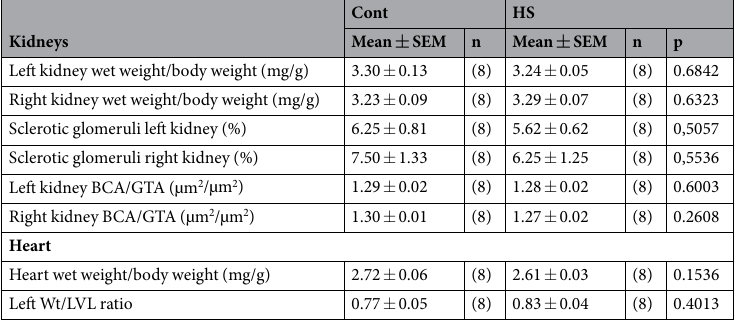
Table 2. Morphometric analysis of renal and cardiac parameters in HS rats and respective control group. Ratios and indexes were calculated as described in the methods section. BCA/GTA = Bowman’s capsule area/ glomerular tuft area; Wt/LVL = wall thickness/lumen. Pairs of means were compared by unpaired t -test. SEM = standard error